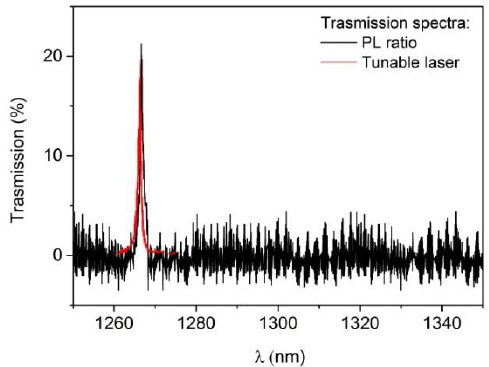
Figure 9. Experimental transmission spectra: black curve indirectly calculated from the ratio between the photoluminescence (PL) spectra before and after filtering, red curve from direct fiber-in:fiber-out measurement.